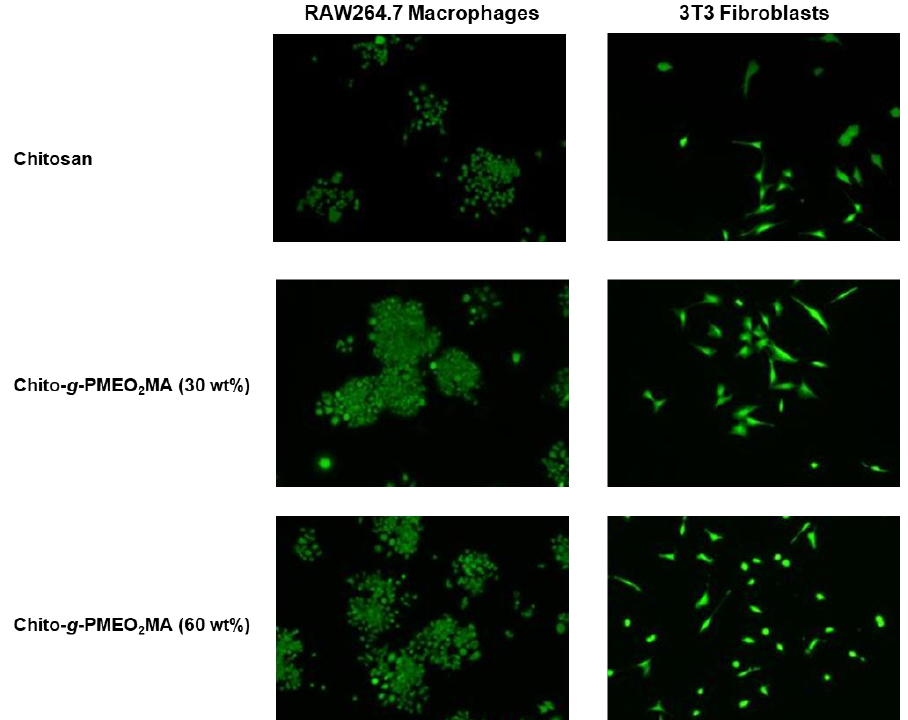
Figure 8. The 3T3 Fibroblasts and RAW 264.7 macrophages detached by cooling from chitosan, Chito- g -PMEO 2 MA (30 wt %), and Chito- g -PMEO 2 MA (60 wt %) after 3 days of culture and seeded on TCPS after the detachment step. Representative live/dead staining of cells on TCPS after 3 days of culture. Calcein AM stains live cells green and EthD-1 stains dead cells red.